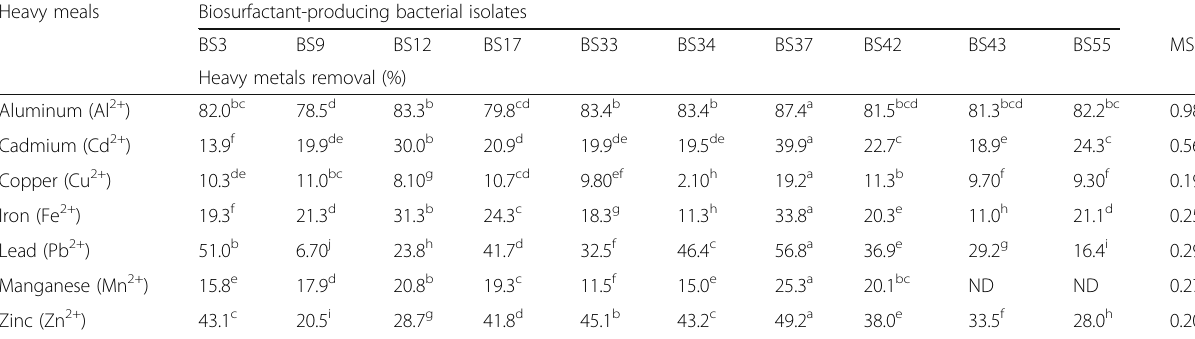
Table 2 Efficiency of biosurfactants of the ten selected isolates to remove heavy metals from wastewater Heavy meals